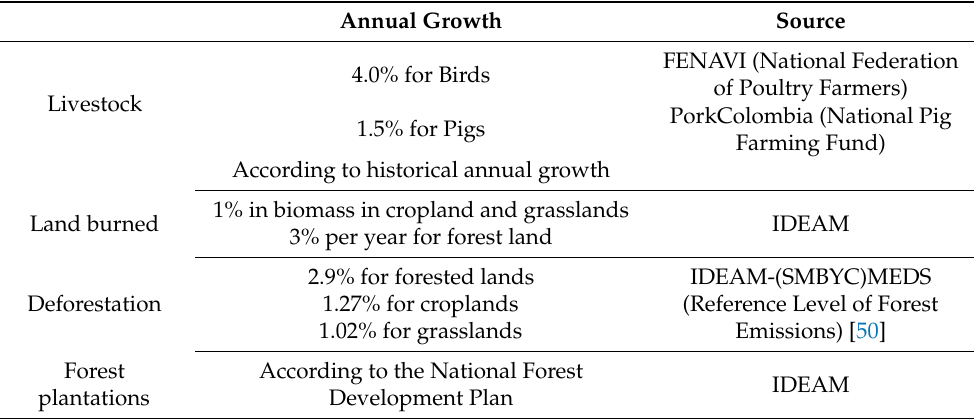
Table 10. Expected growth and projections for AFOLU